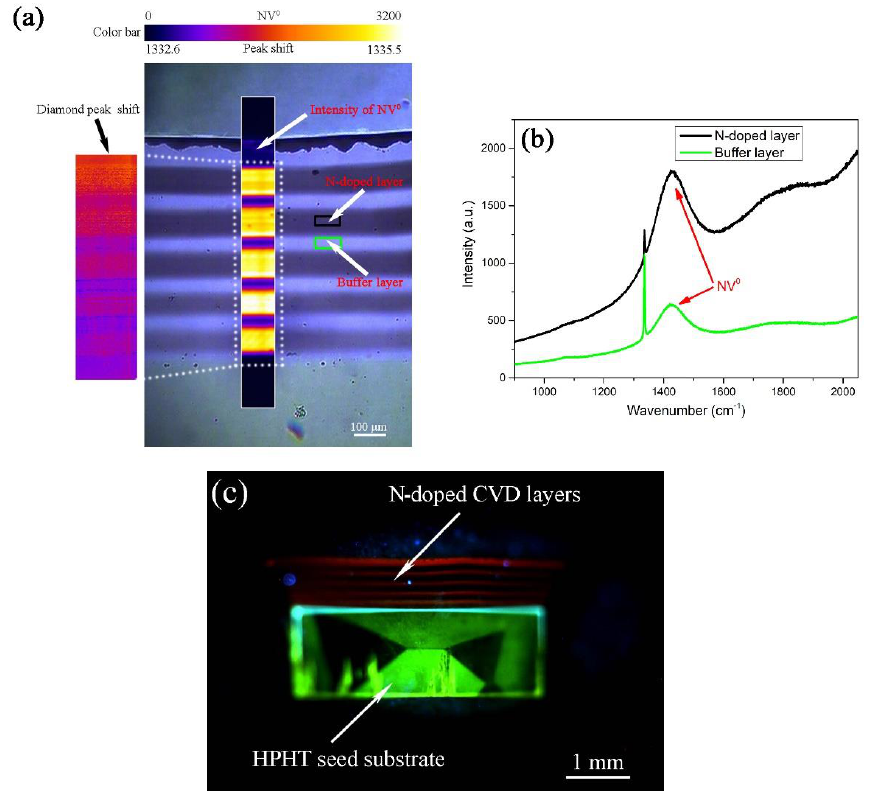
Figure 3. ( a ) Laser-scanning Raman images show the Raman mapping of the diamond peak shift (left inset) and the fluorescence intensity of the NV 0 defect of the cross section slice (white dotted line area). Correspondingly, the diamond peak shift (1332.6 – 1335.5 cm – 1 ) and the fluorescence intensity of NV 0 (0 – 3200 counts) are shown in the same color bar on the top. ( b ) Raman spectra recorded at room temperature for the 0.12 sccm nitrogen-doped layer and the buffer layer, respectively. ( c ) UV-excited photoluminescence image of the polished cross sectional slice of the nitrogen-doped multilayer CVD diamond grown on the Ib-type HPHT